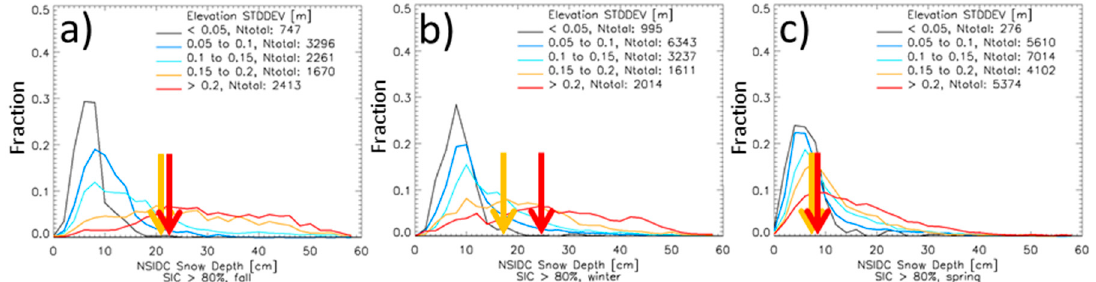
Figure 4. The distribution of the NSIDC AMSR-E snow depth for different ranges of the ICESat surface elevation standard deviation. The orange and red vertical arrows mark the approximate location of the mode of the distributions for the ranges 0.15 to 0.2 m and > 0.2 m, respectively. ( a ) Fall periods, ( b ) winter periods, and ( c ) spring periods (see Table 1).